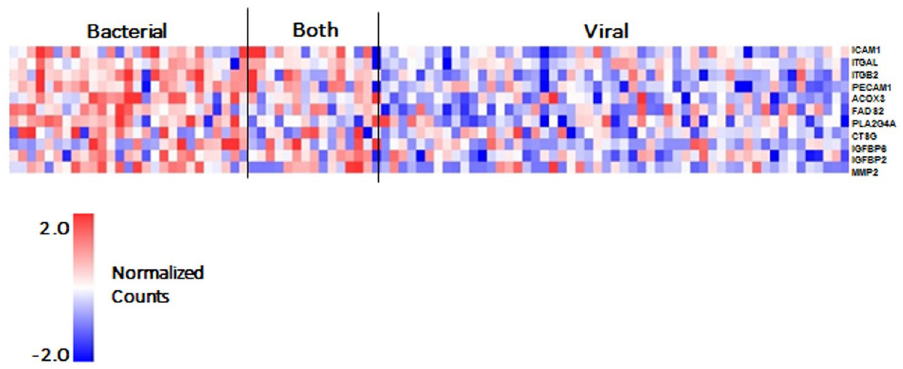
Figure 4. Shown is a heat map for the 10 predictive genes identified by pathway analysis as predictive of bacterial infection (rows) demonstrating differential expression in the 3 groups, bacterial, mixed viral bacterial and viral alone. Each column represents an individual